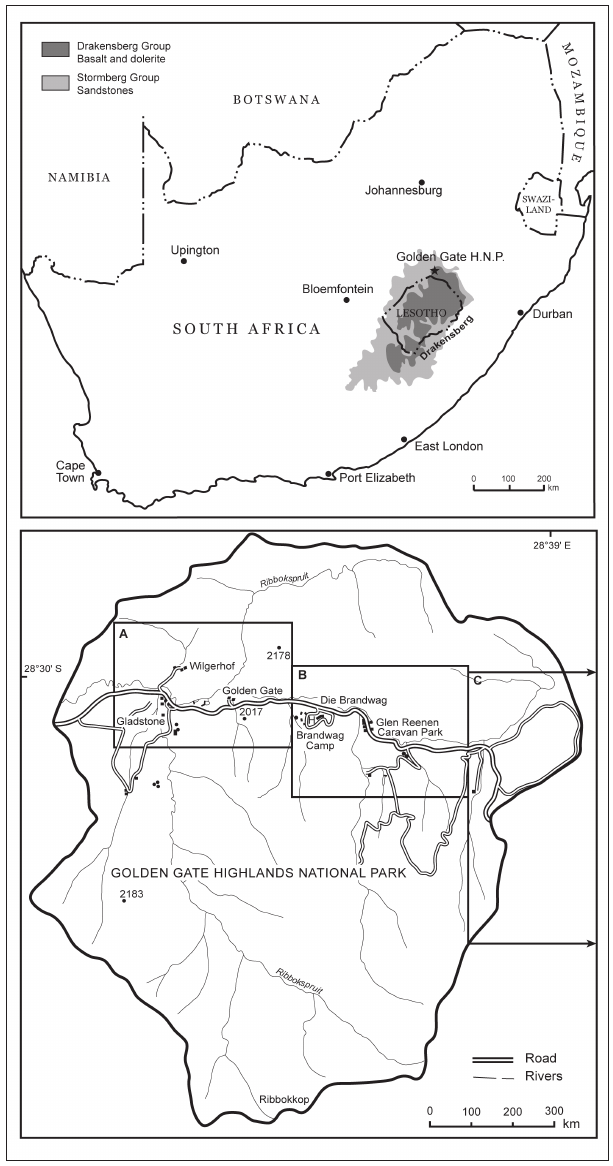
FIGURE 2: Location of the Golden Gate Highlands National Park and map of the park showing the insets for the geomorphological maps in Figure